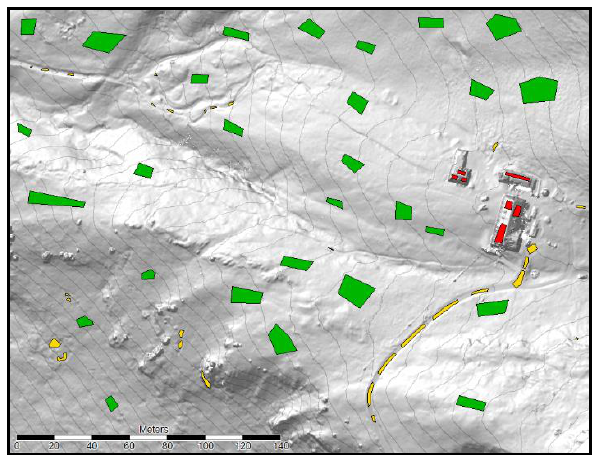
Figure 2. Test site subset and sample areas representing different landcover classes (yellow: bare earth and rock , red: buildings , green: grassland ). Contour equidistance is 5